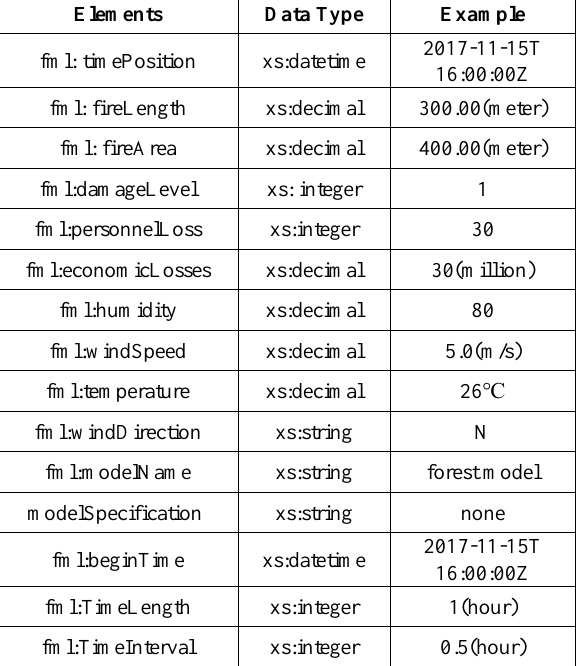
Table 3. The data type and example of